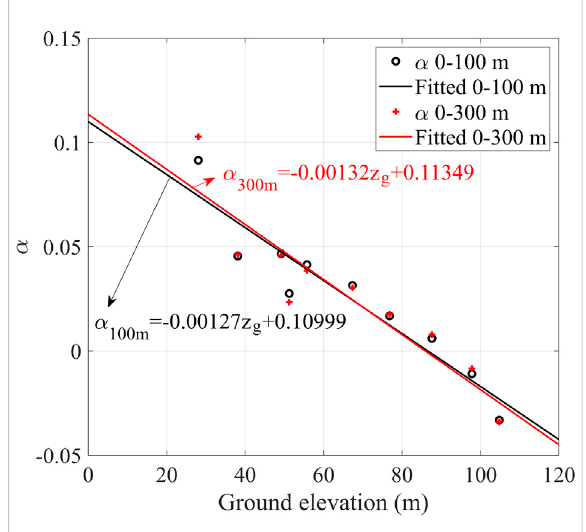
Linear relation between power exponents (vertical axis) and ground elevation (horizontal axis). Black solid line represents the fi tted relation curve for power exponents obtained from power- lawpro fi lesbetween0and100 m,andblackcirclerepresents associated power exponents. Red solid line represents the fi tted relation curve for power exponents obtained from power-law pro fi les between 0 and 300 m, and red plus sign represents associated power